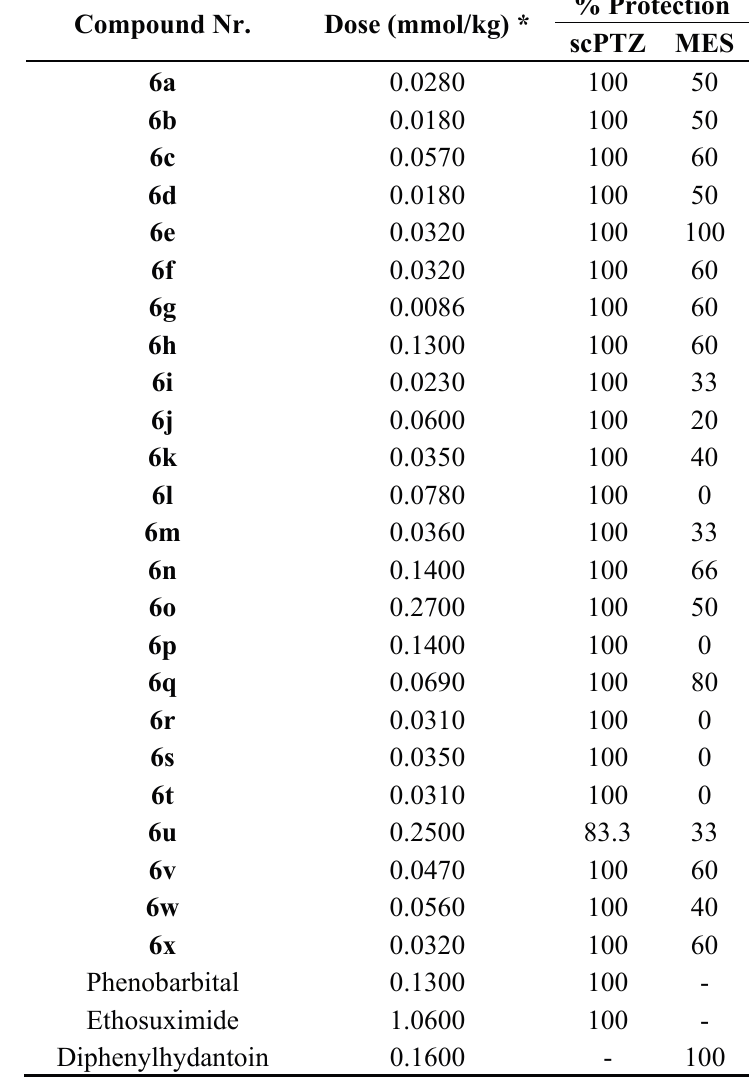
Table 1 . Anticonvulsant potential (scPTZ and MES screens) of compounds 6a – x as well as the reference standards, Phenobarbital, Ethosuximide and Diphenylhydantoin in adult male albino